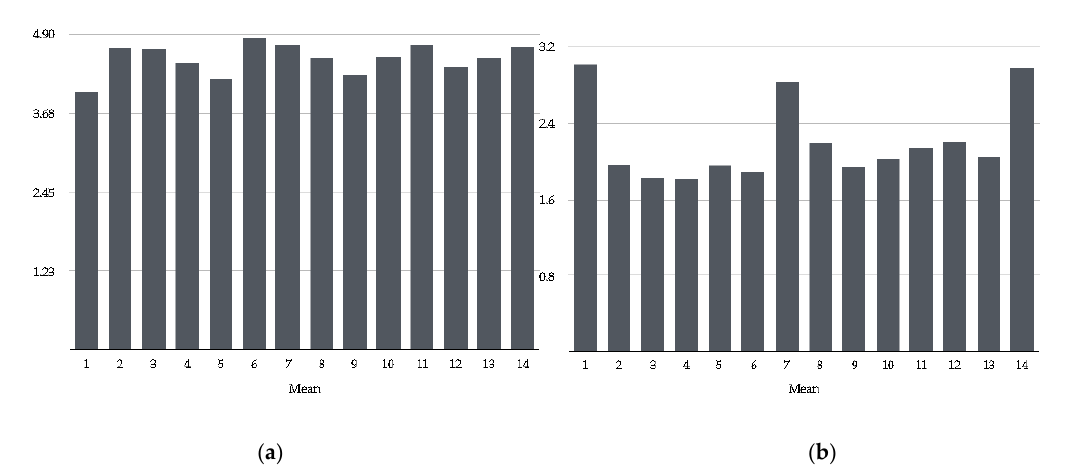
Figure 3. ( a ) Attitudes toward energy saving-Behavioral changes perception. ( b ) Behavioral Changes- Incentives